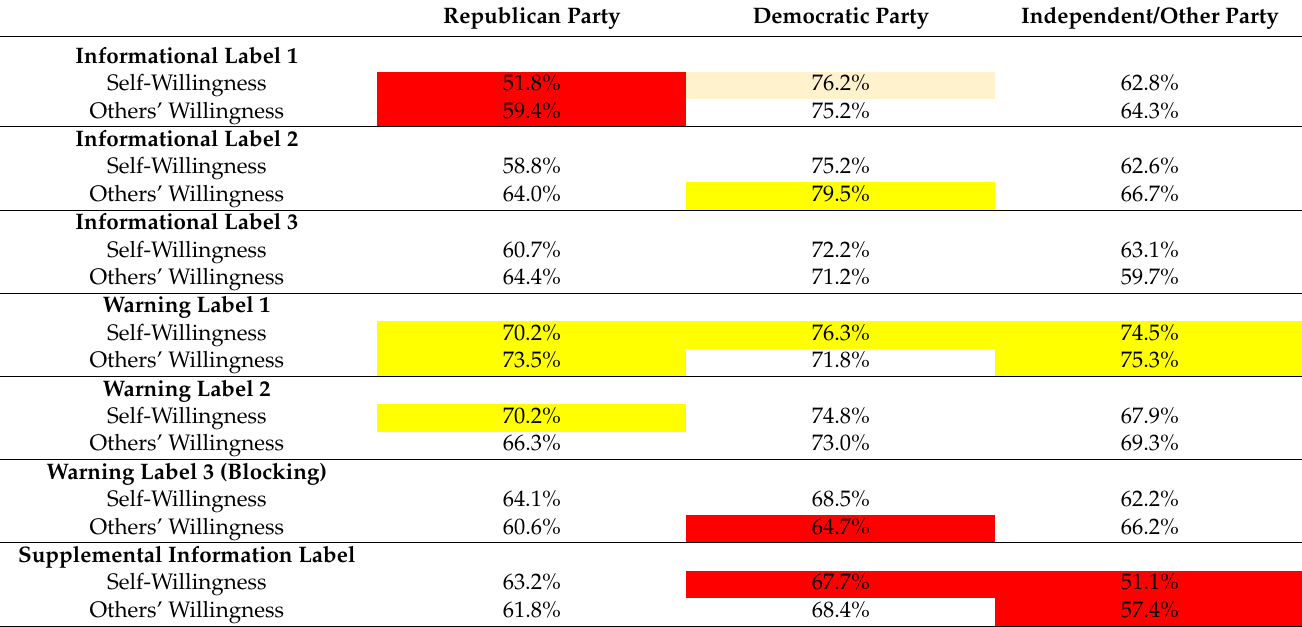
Table 5. Comparison of self- and others’ willingness to use labels by party